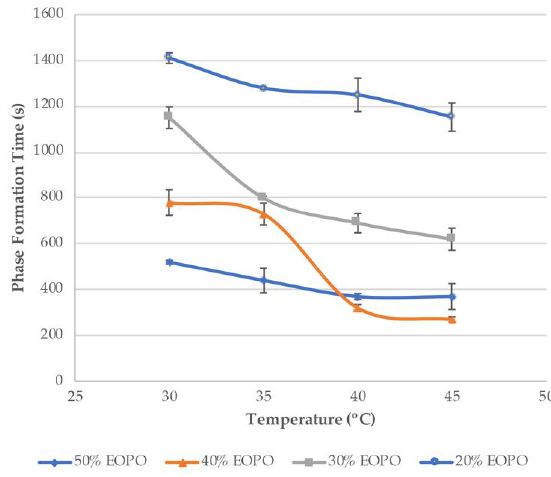
Figure 4. Phase formation time and temperature needed for different EOPO 970 concentrations (20, 30, 40 and 50 % v/v ) on Rhodotorula mucilaginosa UANL-001L cultures in mineral medium. 3.4. Biomass and EPS Production and Recovery on Extractive Fermentation with EOPO 970